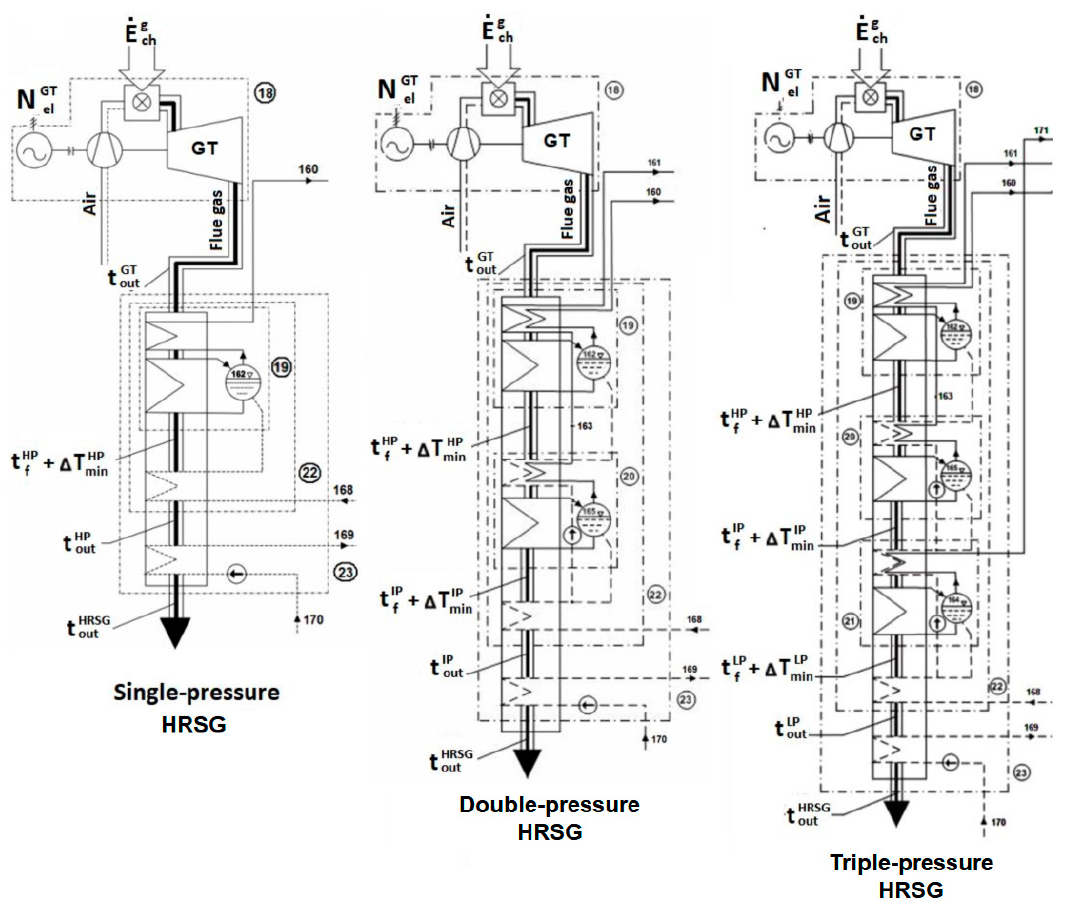
Figure 4. Schematic diagram for heat recovery steam generators (HRSG).